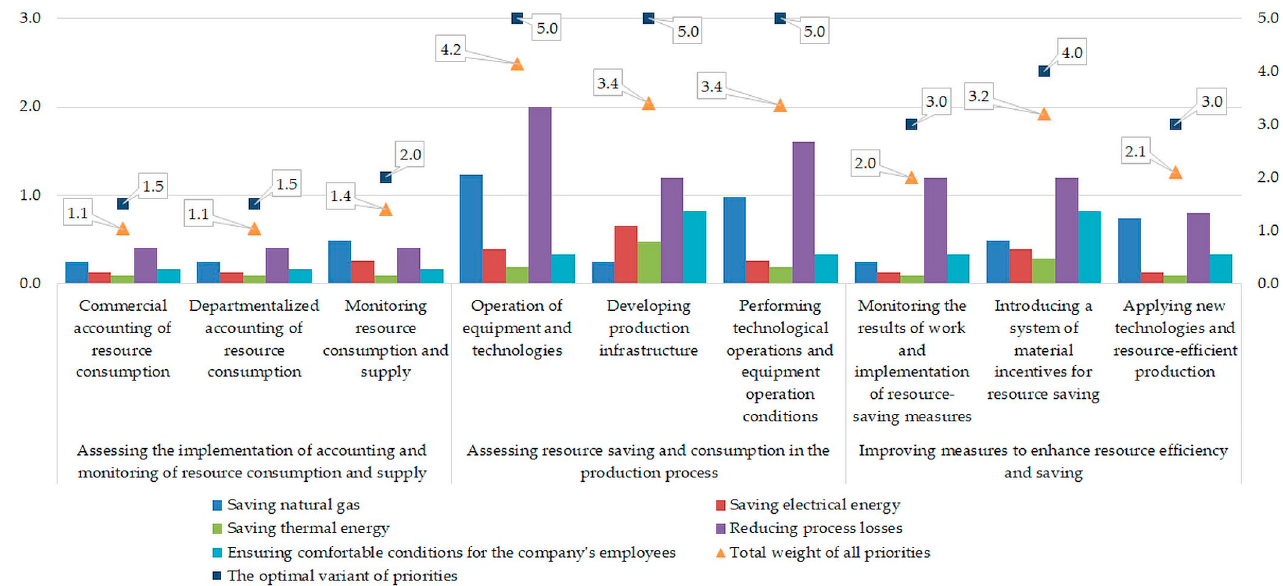
Figure 8. Evaluation of prospective resource-saving scenarios.